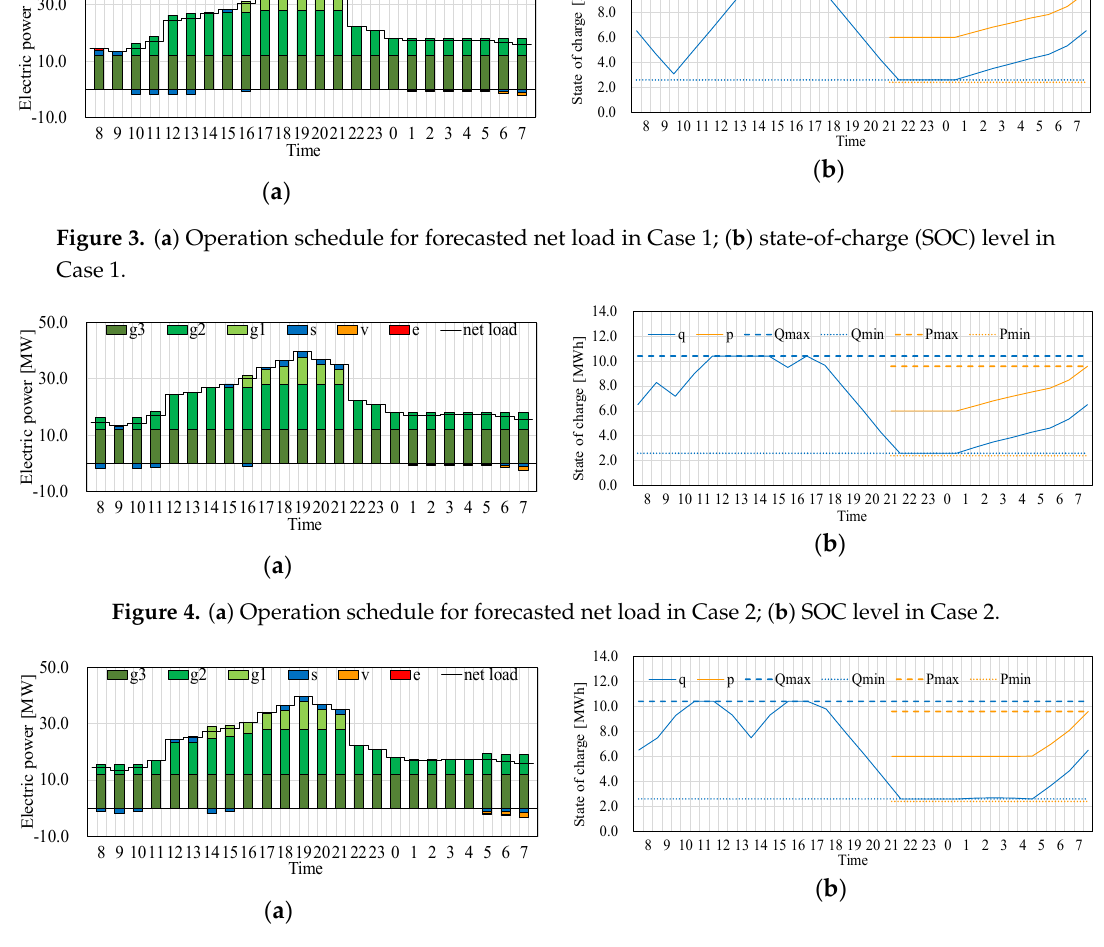
Figure 5. ( a ) Operation schedule for forecasted net load in Case 3; ( b ) SOC level in Case 3. Table 3. Comparison of numerical results.